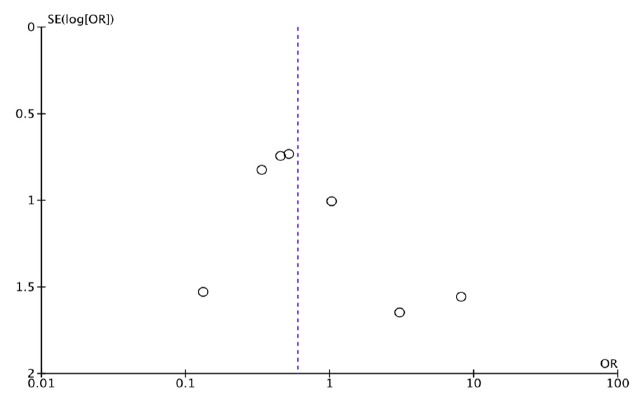
Figure A2. Funnel plot of urinary leakage for early (<3 weeks) versus late (>3 weeks) stent removal.